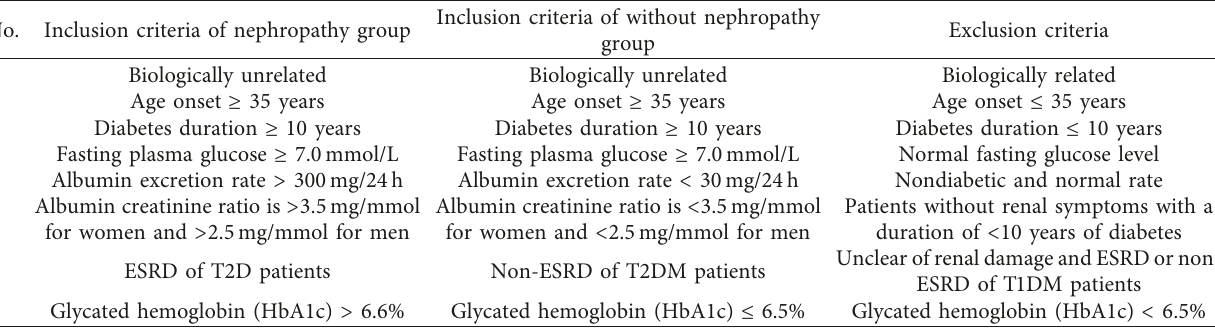
Table 1: Inclusion and exclusion criteria.